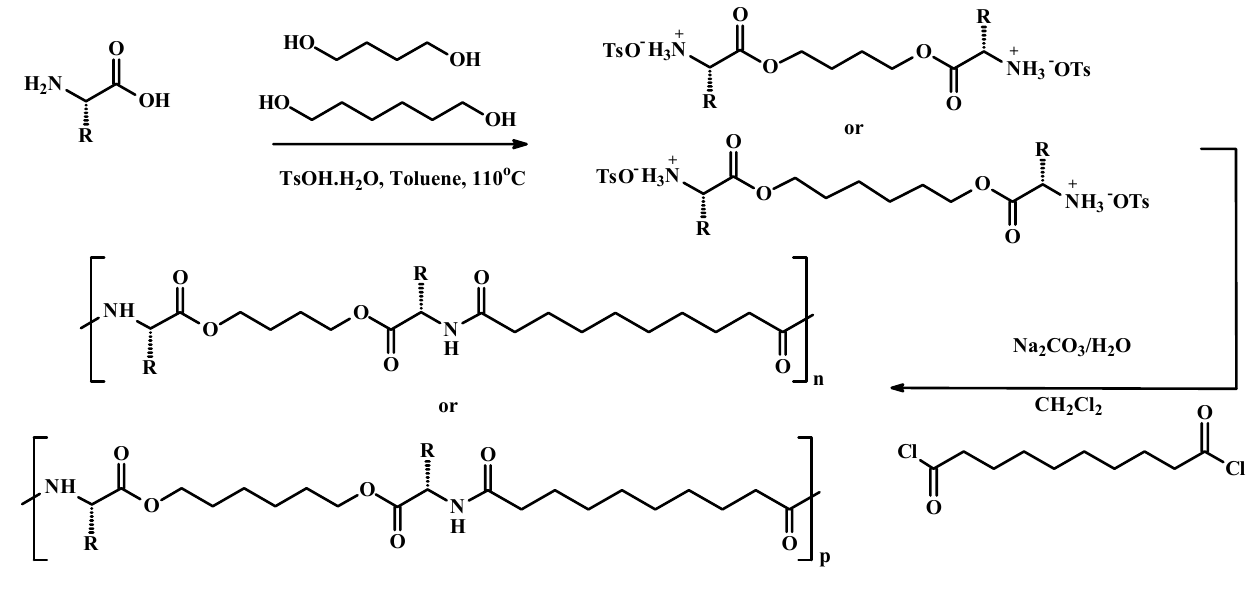
Figure 1. FTIR Spectra of PEAs synthesized from L -phenylalanine and L -methionine. (A) PEA-Ph48; (B) PEA-Ph68; (C) PEA-Me48; and (D)